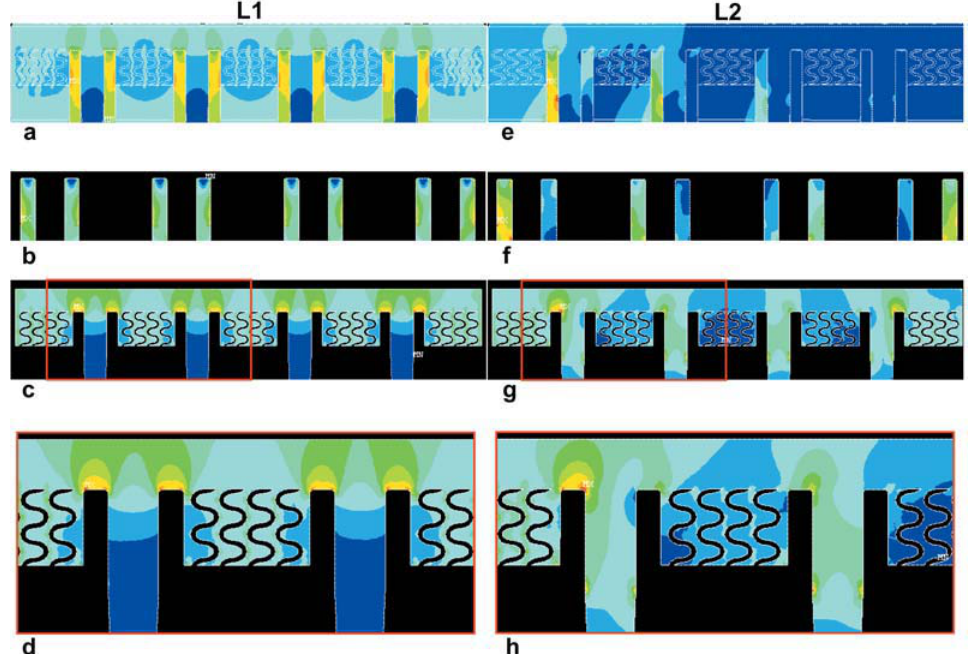
FIGURE 4- Stress distribution for M2 regarding L1 and L2. (a,e) σ (MPa) for adhesive layer (red box view in d and h, respectively). Note the peak of σ dentin (e and f) and more intense σ